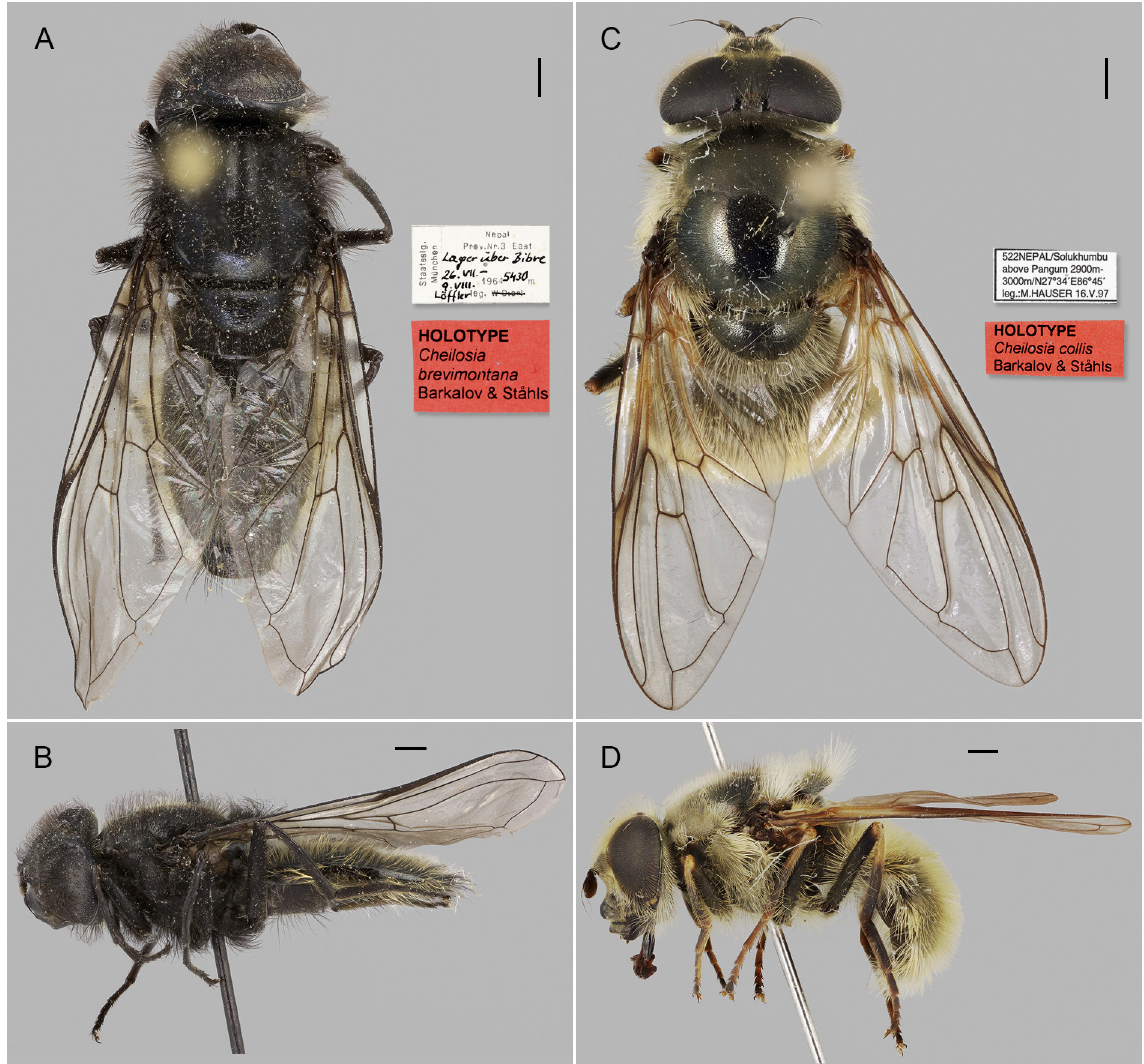
Fig. 10. A–B . Cheilosia ( Montanocheila ) brevimontana sp. nov., holotype, ♀ (ZSMC); dorsal and lateral views. – C–D . Cheilosia ( Floccocheila ) collis sp. nov., holotype, ♀ (CSCA); dorsal and lateral views. Photo: Pekka Malinen, FMNH Luomus. Scale bars = 1